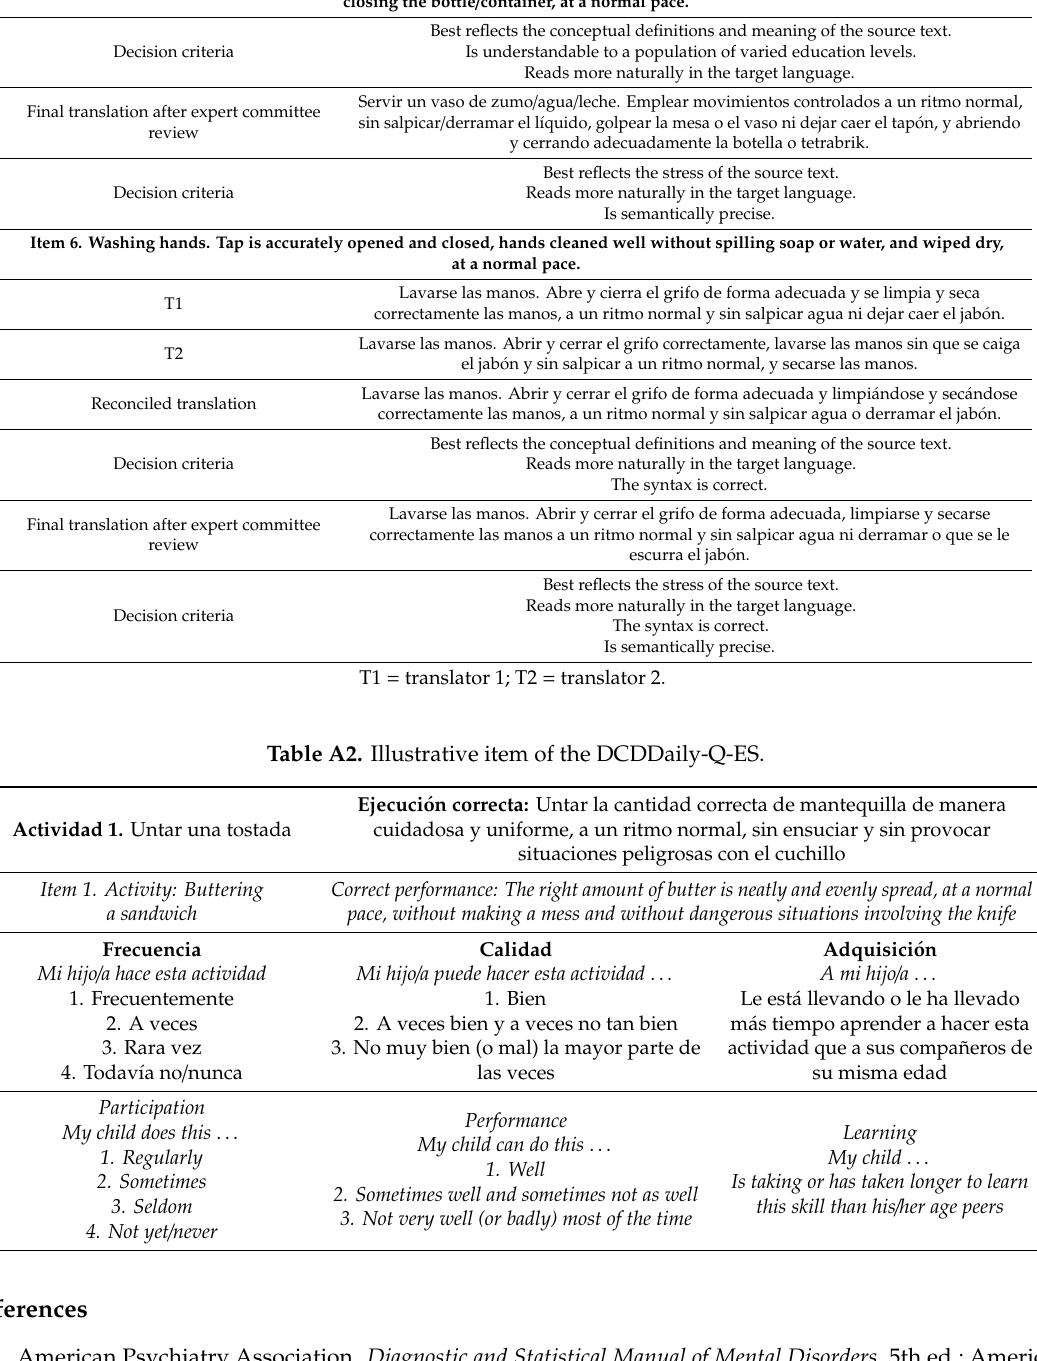
Table A1. Cont. Item 3: Pouring juice. Controlled motions, without spilling or hitting the glass / table or dropping the cap, neatly opening and closing the bottle / container, at a normal pace. Best reflects the conceptual definitions and meaning of the source text. Decision criteria Is understandable to a population of varied education levels. Reads more naturally in the target language.